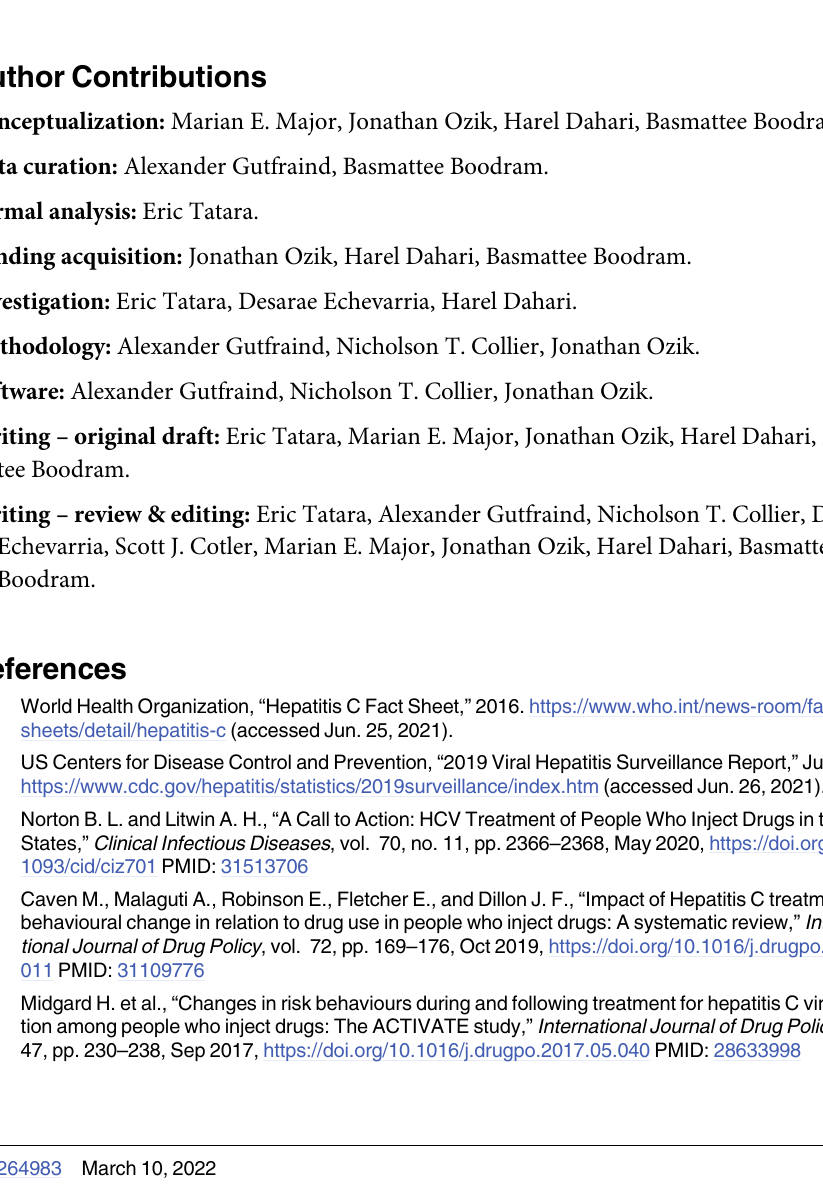
S1 Table. Parameters for the generation of the synthetic population. S2 Table. HCV model infection